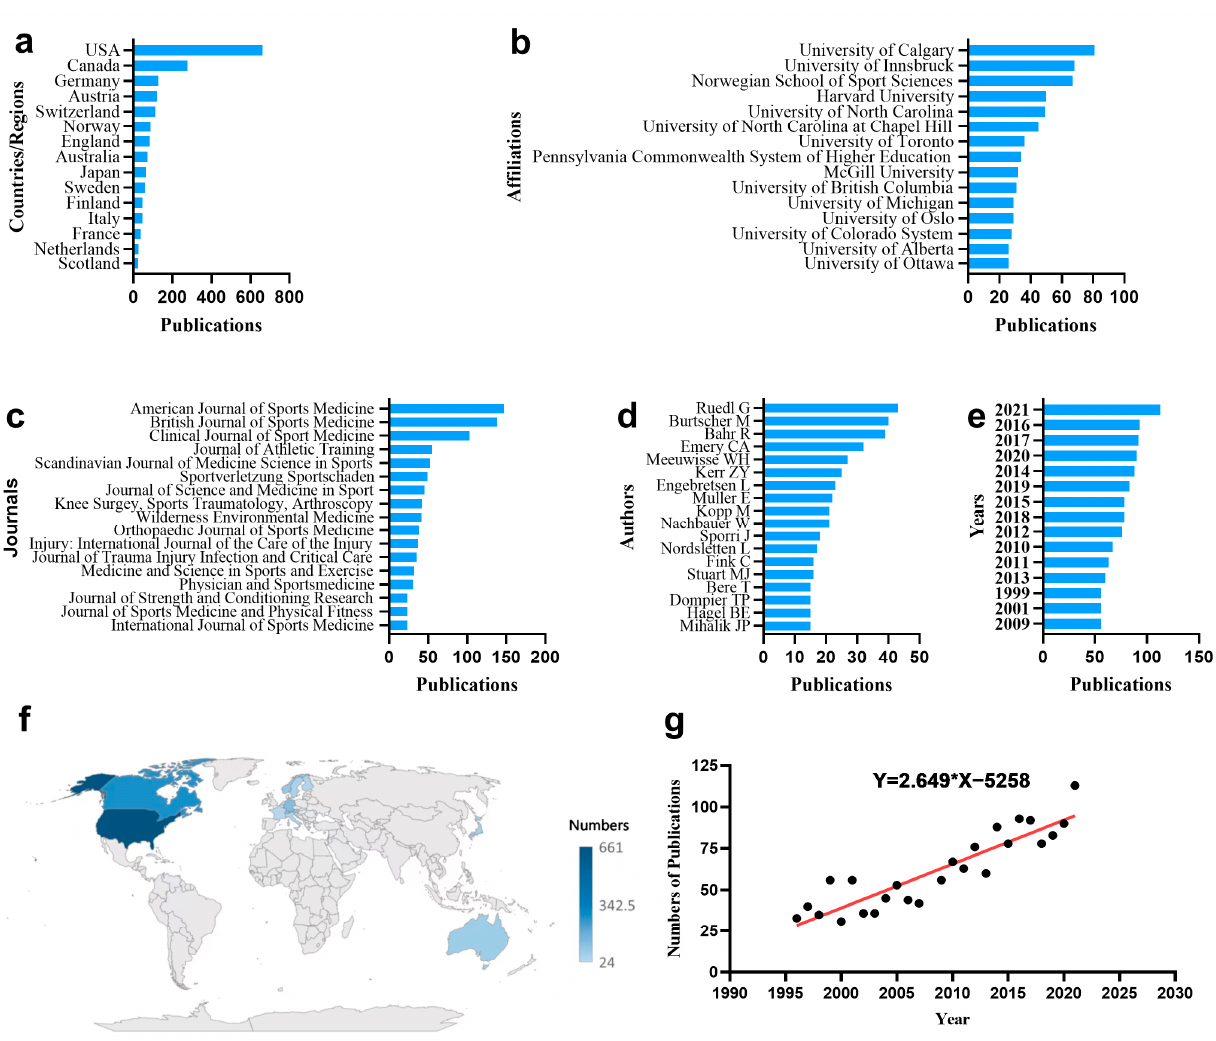
Figure 1. ( a – e ) The number and trends of global publications. ( f ) Top 15 countries’/regions’ distribution of ice and snow sports injuries research in world map. ( g ) The linear regression model of trends in the number of publications.